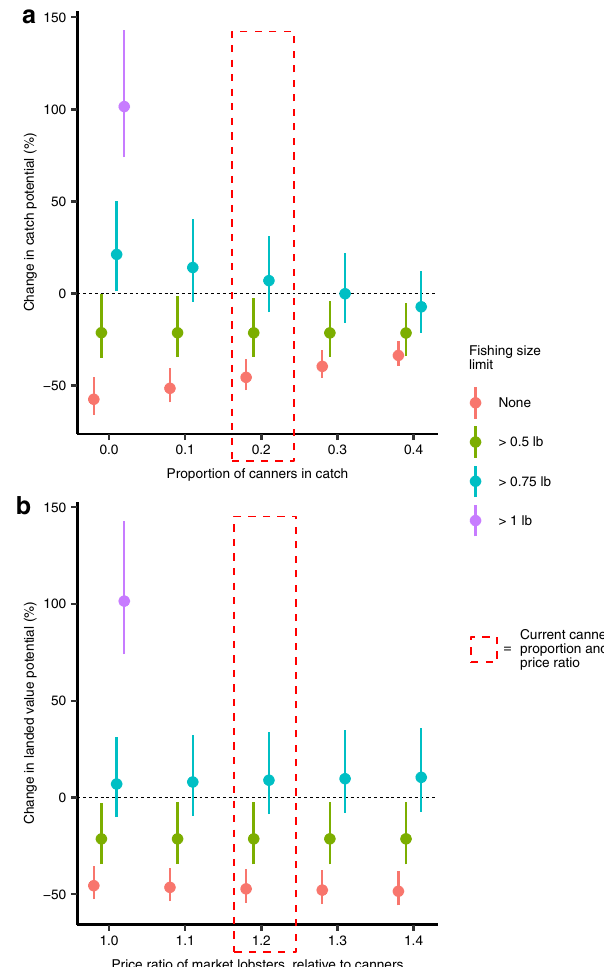
Figure 4. The effect of implementing different scenarios of fishing size limits on: ( a ) maximum catch potential based on different catch proportions of canner lobsters, and ( b ) landed value potential with different price ratios of market to canner lobsters. Values are the change weighted by tonnage of the different priced lobster sizes by end of twenty-first century (2091–2100) under a high climate change scenario (RCP 8.5), relative to 2010 for American lobster biomass. Proportion of canners in catch were kept constant at 0.2 (the current value) for the analysis in panel b, except for when size limits were > 1 lb (thus no canners in catch). Points represent multi-model means from simulations from three earth system models and error bars represent the minimum and maximum of the three outputs. Parameter values were used from our null model (Table 2): climate change scenario = RCP 8.5; OA mortality effect size = 15%; OA effects on life stage = all; fishing pressure =